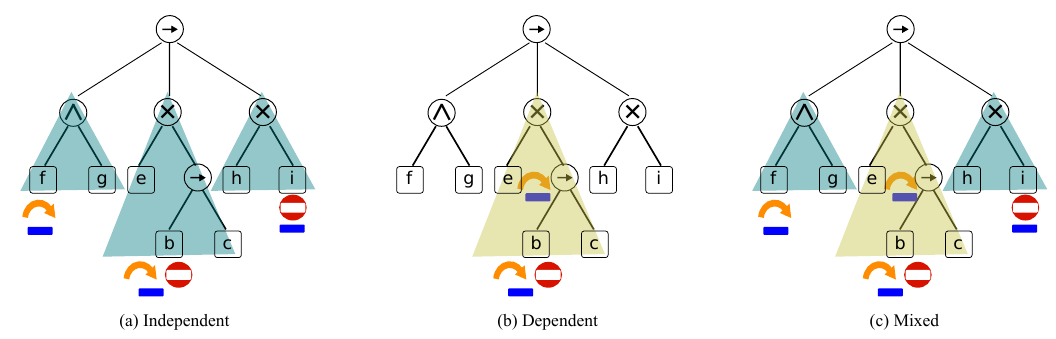
Figure 8. Different configurable node